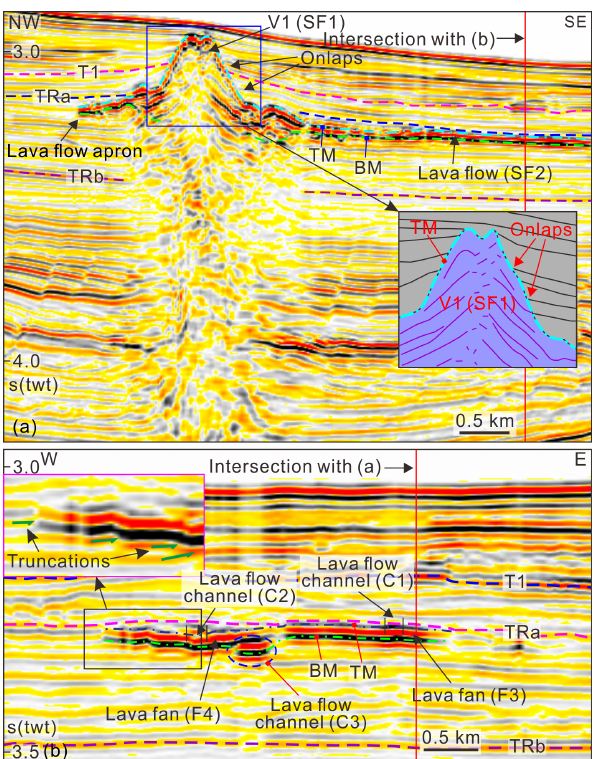
Figure 3. Seismic characteristics of a deepwater volcano (V1) and associated lava flow channels and fans. (a) Seismic profile cross- cuts the volcano edifice and associated lava flow; (b) seismic profile cross-cuts the lava flow (enhanced seismic anomalies). TM – top of volcano–lava flow; BM – base of volcano–lava flow. See locations of seismic profiles in Fig. 4.